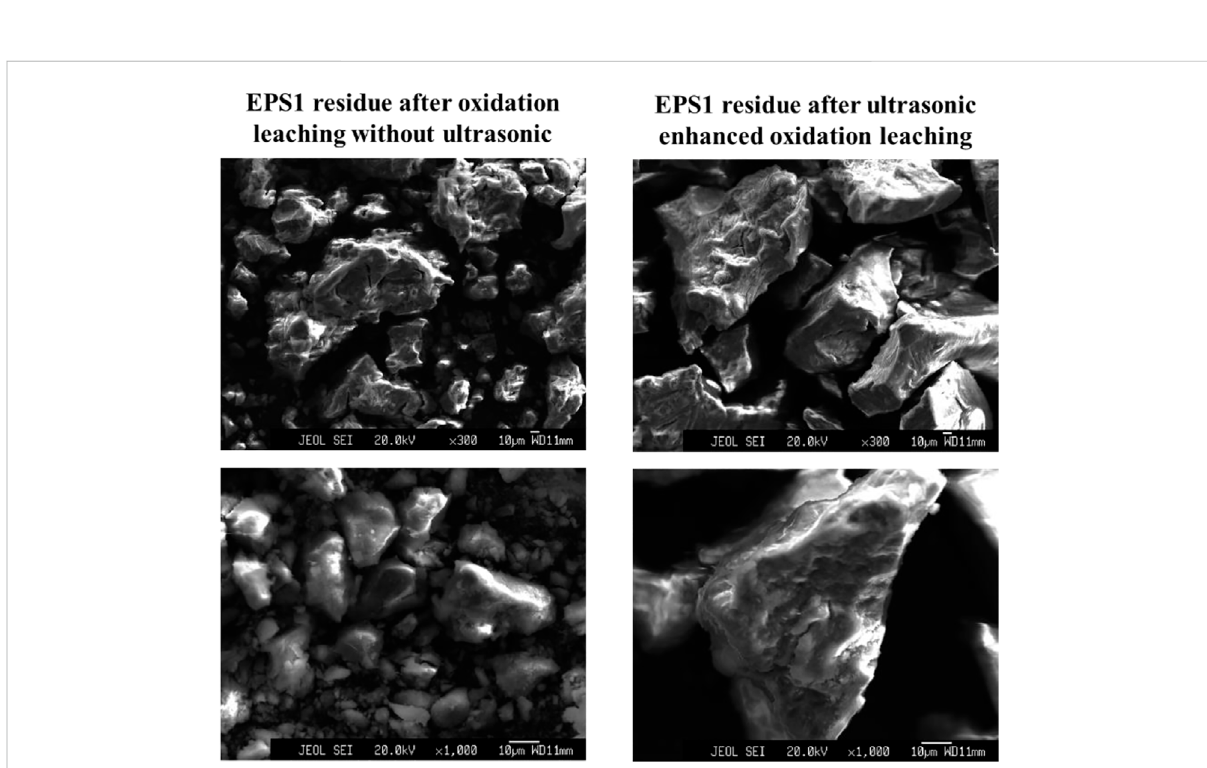
FIGURE 6 Particle morphology of chromium sludge (EPS1) after oxidation leaching with and without ultrasonic treatment.